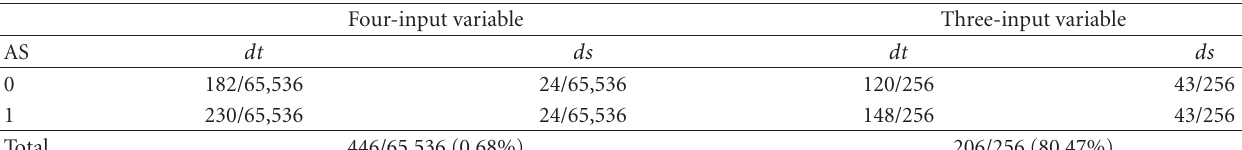
Table 2: Output logic pattern of the BLE (CP = 0).